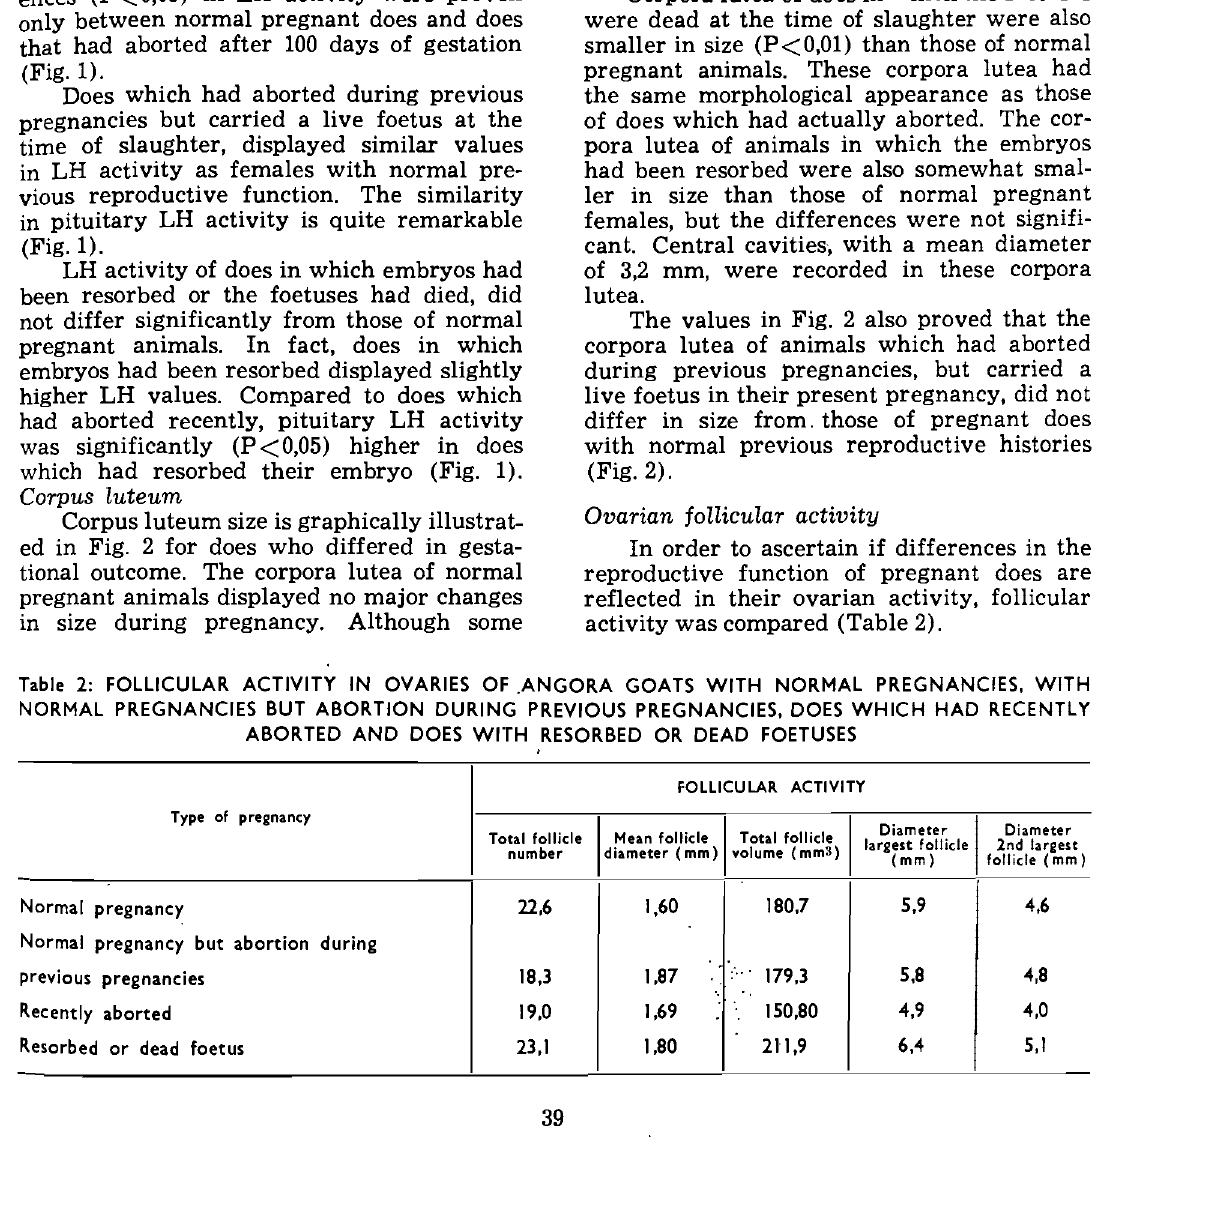
Table 2: FOLLICULAR ACTIVITY IN OVARIES OF .ANGORA GOATS WITH NORMAL PREGNANCIES, WITH NORMAL PREGNANCIES BUT ABORTION DURING PREVIOUS PREGNANCIES, DOES WHICH HAD RECENTLY ABOR TED AND DOES WITH RESORBED OR DEAD